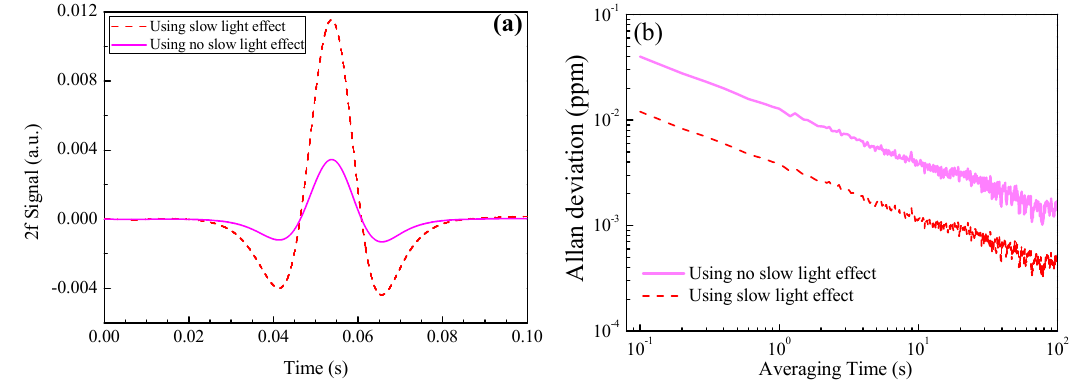
Figure 8. ( a ) The extracted 2f signals, both using the slow-light effect and without using such effect. ( b ) Allan deviation plots using the slow-light effect and without using such an effect.